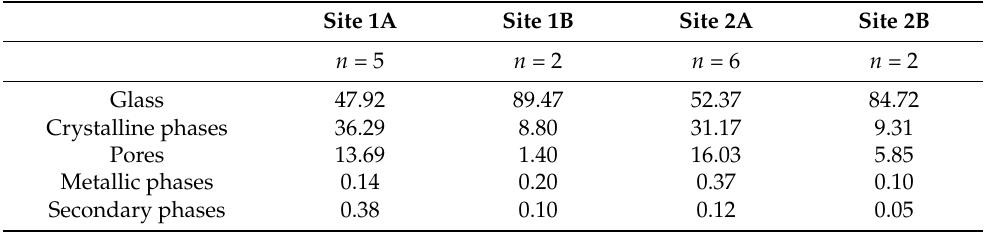
Table 1. Average modal composition of slags from four localities in the Old Copper Basin. Site